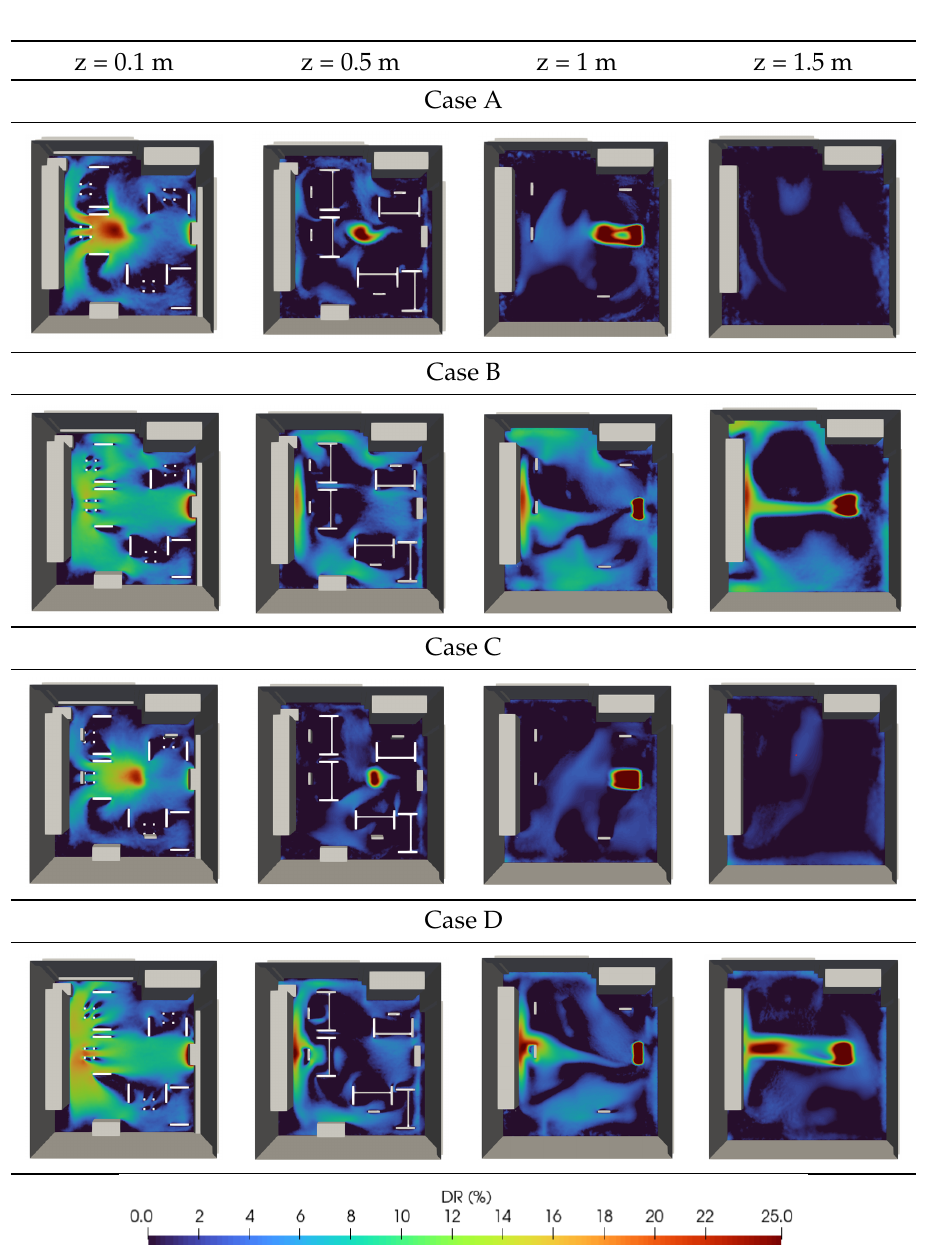
Figure 13. Summer cooling condition. Draught-rate profile on different sections in the z direction obtained for low input air velocity and no solar load (Case A), high input air velocity and no solar load (Case B), low input air velocity and solar load (Case C), high input air velocity and solar load (Case